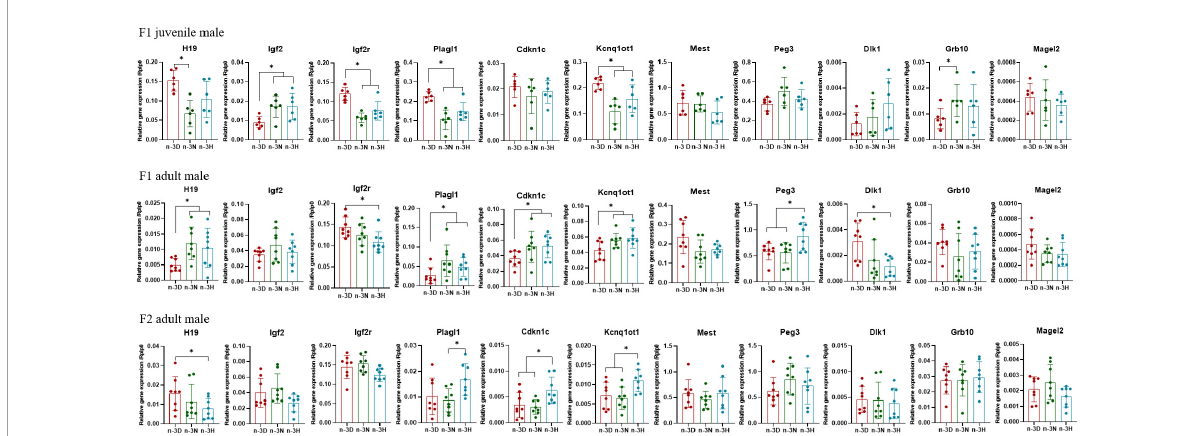
FIGURE3 Effects of paternal dietary ratio of n-6: n-3 PUFAs on the expression of imprinted genes in the adipose tissue of male offspring. The protocols for production of F1 and F2 offspring as well as the experiments were the same as those described in Figure 1 . Mice from the F1 or F2 offspring were fed normal chow diet for 16 weeks. The mRNA expression of the imprinted genes in the epididymal fat was measured using real-time qPCR. n = 6–8 mice in each group. Data have been presented as mean values with standard deviation. * P < 0.05. Statistical differences were analyzed by one-way analysis of variance with Bonferroni post hoc , or Dunnett’s T3 test for data lacking homogeneity of variance. For non-normally distributed data, the Kruskal–Wallis test was used with Mann-Whitney U post hoc .